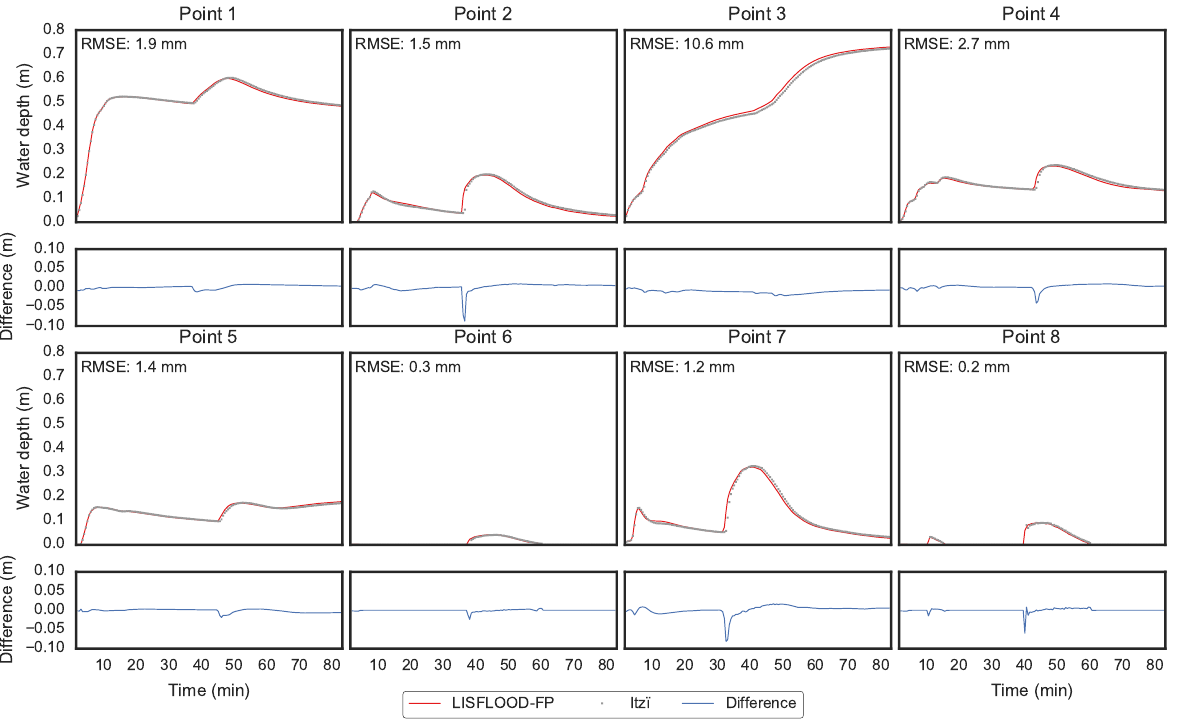
Figure 7. Comparison of water depths at control points. The blue line represents the differences of water depth between Itzï and LISFLOOD-